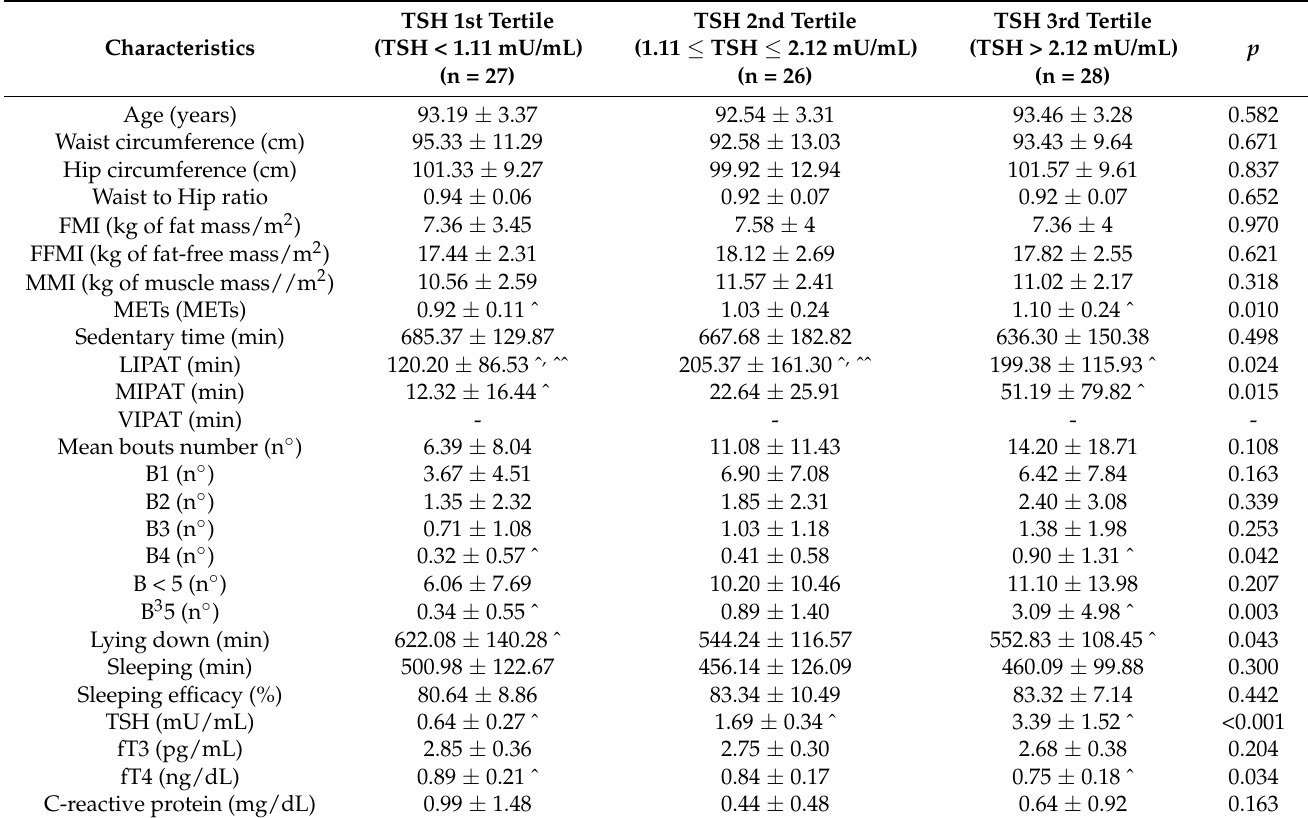
Table 5. Comparisons of sub-samples characteristics, according to TSH tertile memberships, using the one-way analysis of variance and Bonferroni test as post hoc analysis, in the female